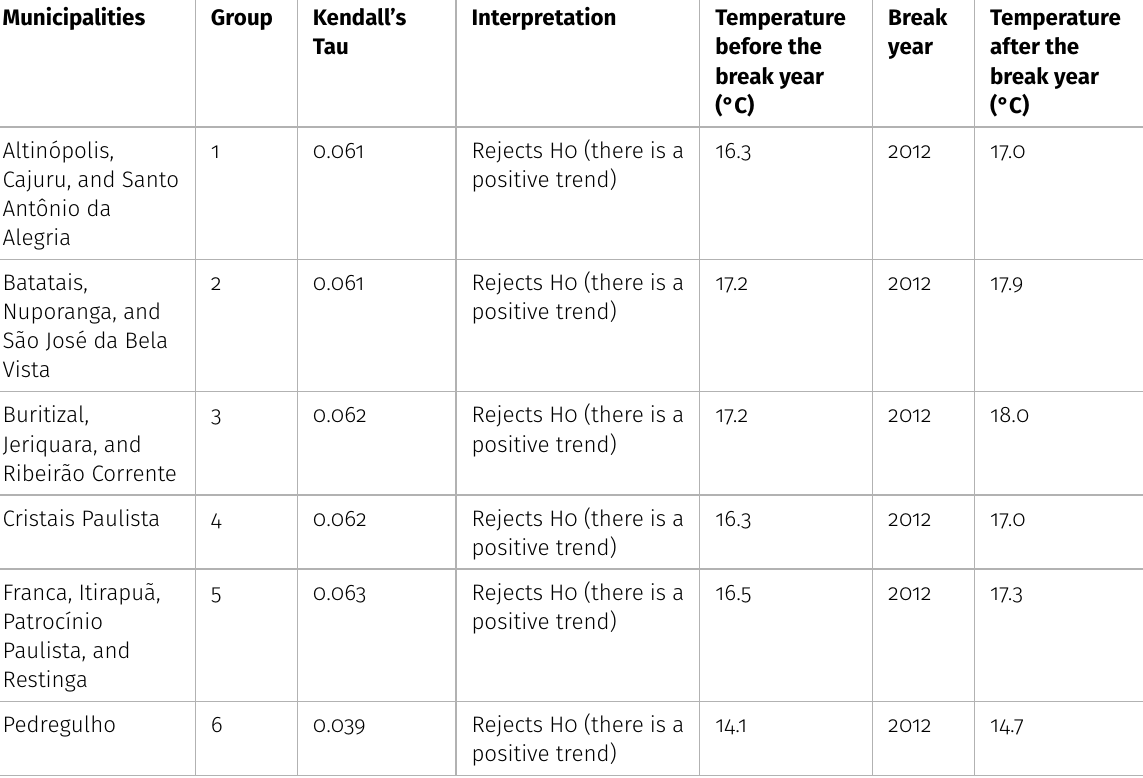
Interpretation Temperature Tau